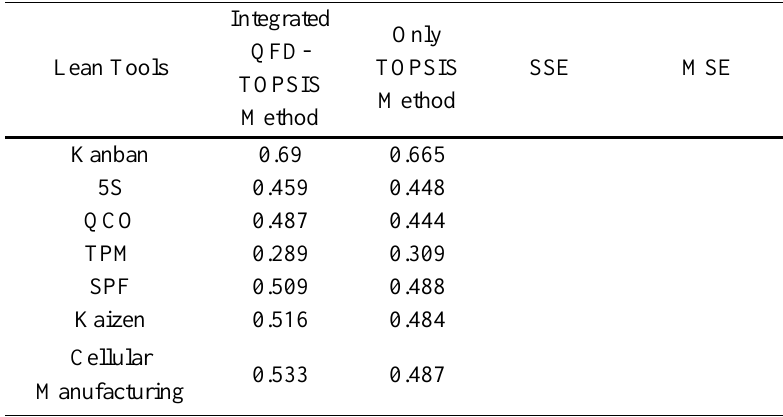
Table 5. SSE and